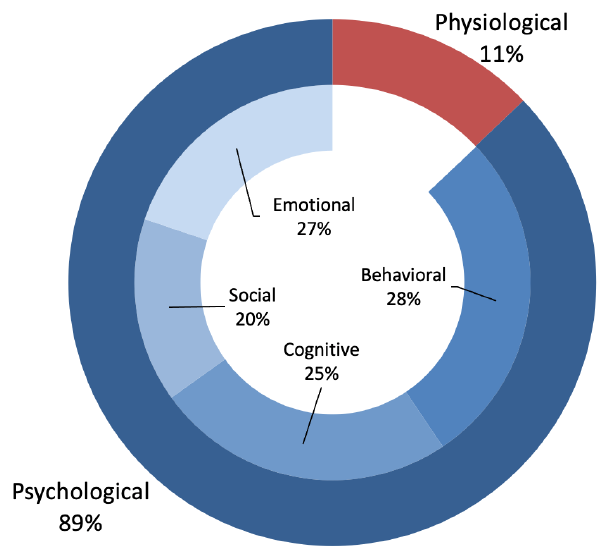
Figure 10. Distributions of physiological and psychological stress studies. RQ 1.8: What specific focus was established on triggering events of stress?